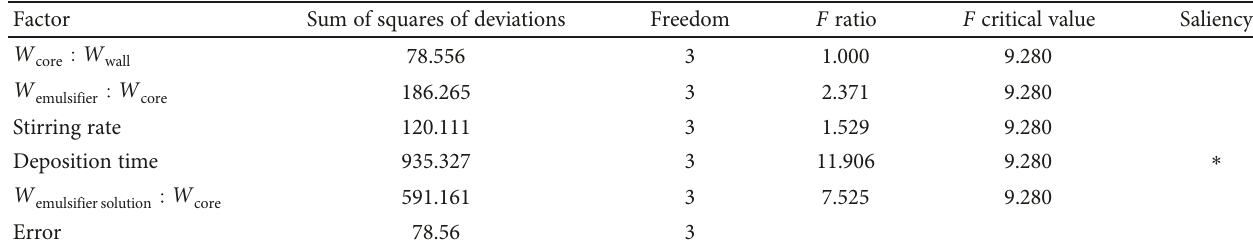
Table 7: Remarkable analysis of microcapsule yields.